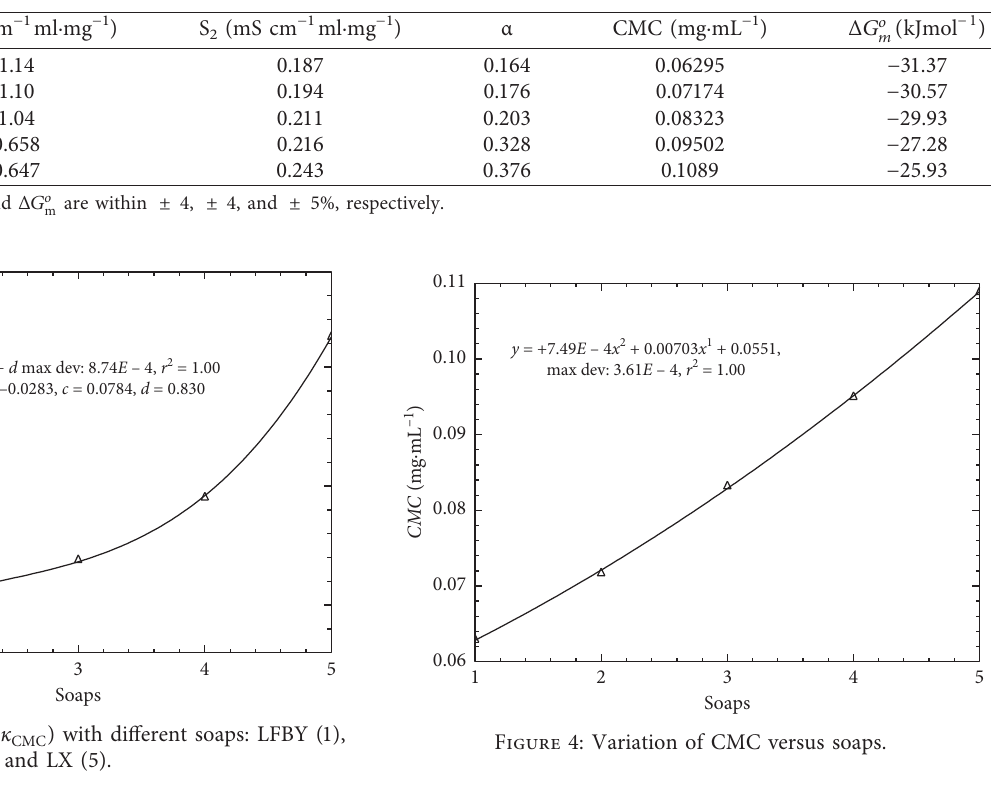
Table 2: Values of premicellar slope ( S 1 ), postmicellar slope ( S 2 ), degree of dissociation ( α ), critical micelle concentration (CMC), and Gibbs